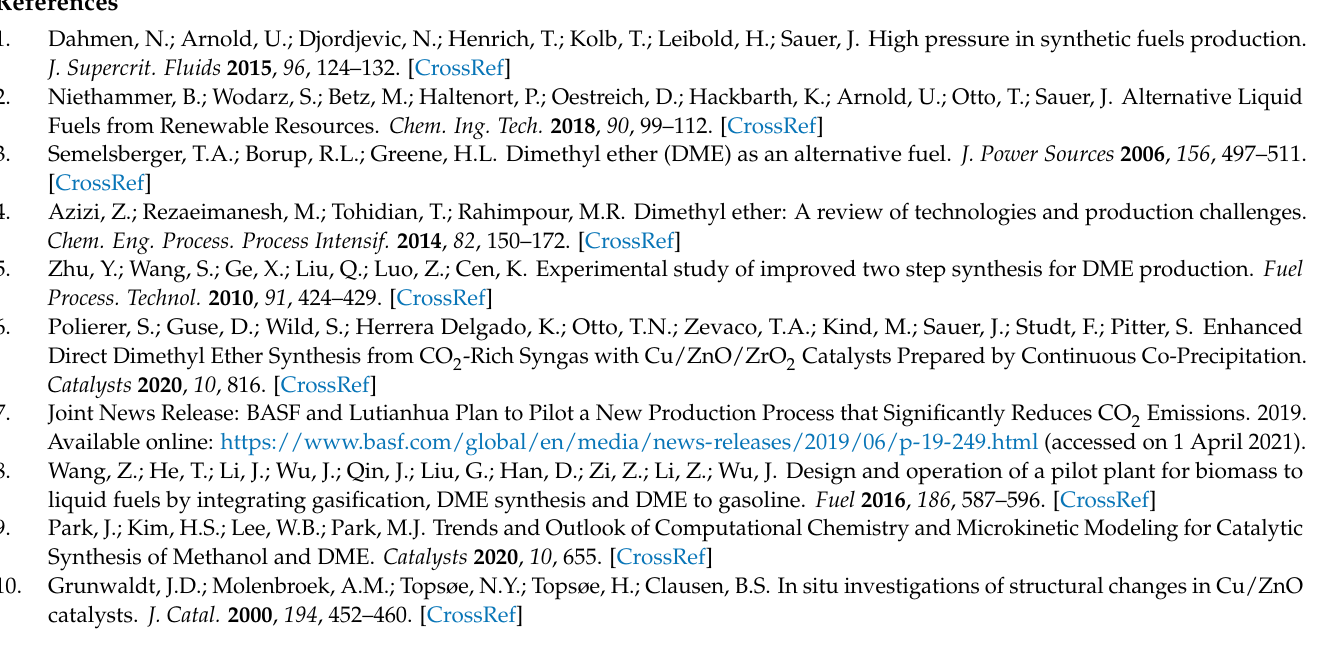
1.0% CO 2 , 45.7% N 2 . Table S1: Model specific parameters of the ANN-HM with 5 HNs. Connection weights of the input and hidden layer, biases of the hidden layer. Table S2: Model specific parameters of the ANN-HM with 5 HNs. Connection weights of the hidden and output layer, biases of the output layer. Table S3: Model specific parameters of the chosen ANN-HM with 26 HNs. Connection weights of the input and hidden layer, biases of the hidden layer. Table S4: Model specific parameters of the chosen ANN-HM with 26 HNs. Connection weights of the hidden and output layer, biases of the output layer. Table S5: Model specific parameters of the ANN-HM with 28 HNs. Connection weights of the input and hidden layer, biases of the hidden layer. Table S6: Model specific parameters of the ANN-HM with 28 HNs. Connection weights of the hidden and output layer, biases of the output layer. Table S7: Calculated a priori criteria for determination of transport limitations (Reference [77] are cited in Table S7). Table S8: Experimental values measured for validation of simulation results at extrapolated conditions. The catalyst bed consisted of 1.007 g CZA, 0.9996 g γ -Al 2 O 3 , 9.98 g SiC, and it was 7.8 cm